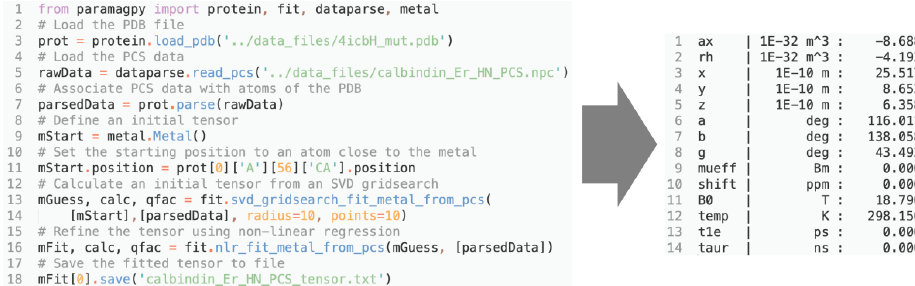
Figure 3. Example Python script for fitting a (cid:49)χ tensor to experimental PCS data. The output with fitted tensor parameters is displayed to the right.